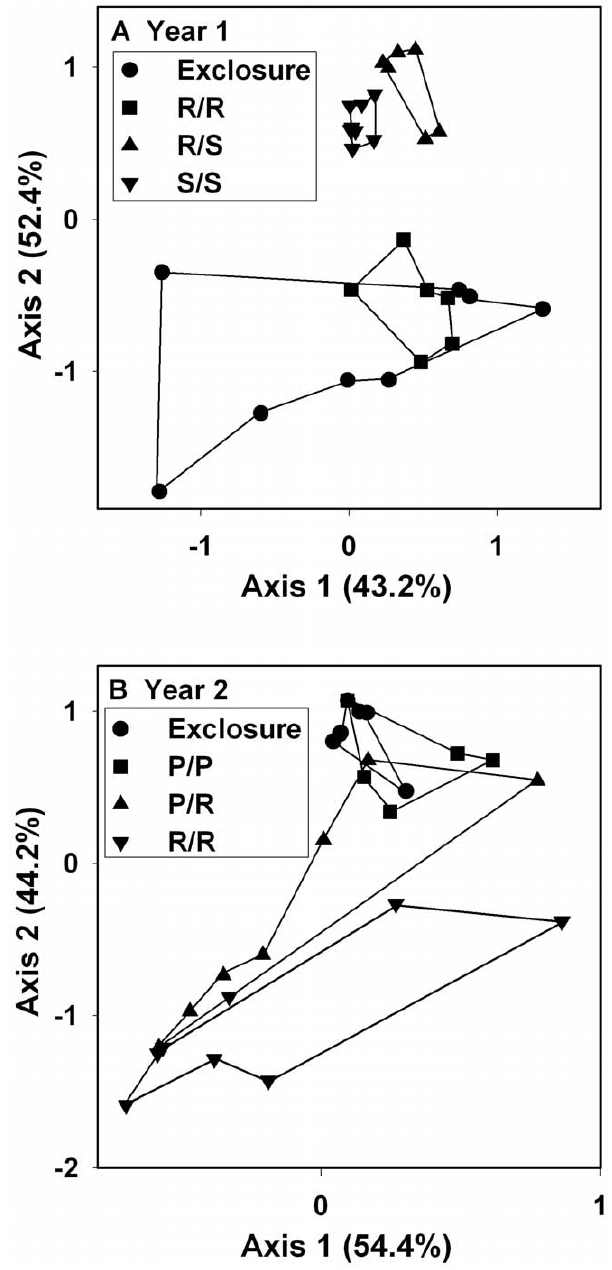
Figure 3. Plot of axes from nonmetric multidimensional scaling (NMDS) describing the similarity of the algal communities among the treatments. Data are for (A) Year 1 and (B) Year 2. Values within parentheses show % of variance explained by each axis. Symbols are as in Fig. 1. Lines connect replicates within treatment.